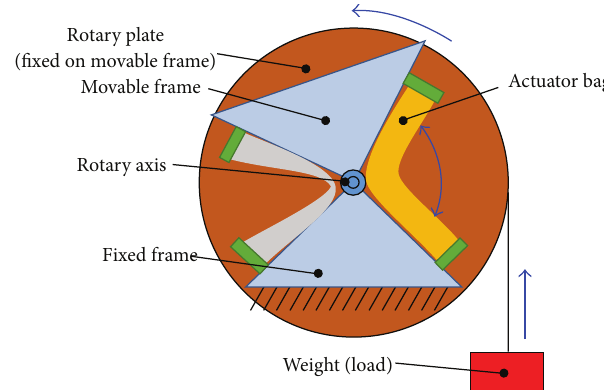
Figure 10: Schematic diagram of load lifting